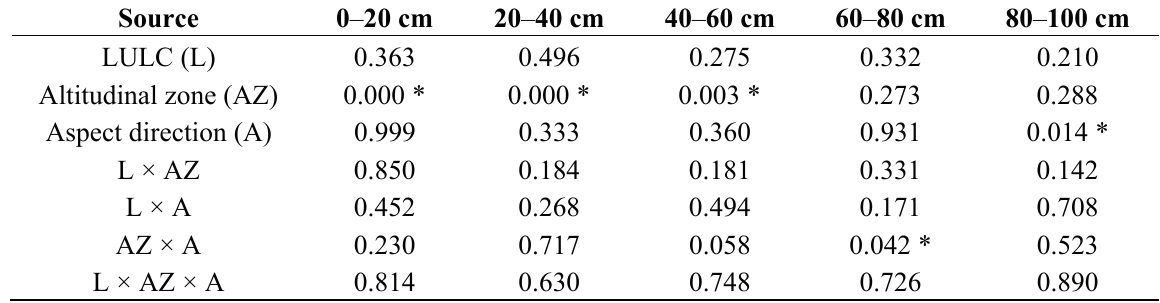
Table 3. Effects of fixed terms (LULC, altitudinal zone and aspect direction) and their associated interactions on SOC density (kg · m − 2 ) at each depth